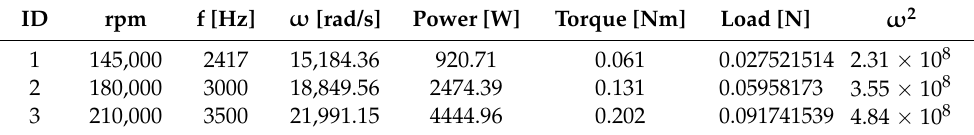
Table 6. Rotor thread and spacer loads.